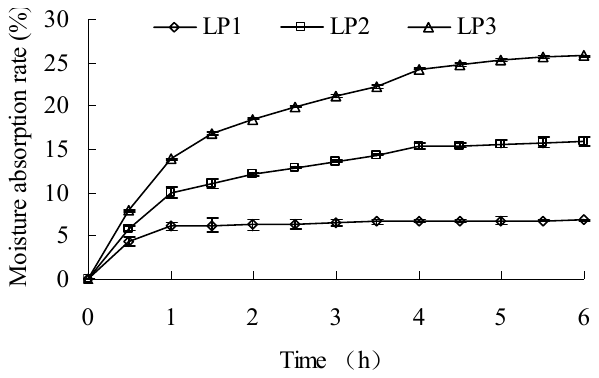
Figure 3. Moisture absorption curves of LP1-3.